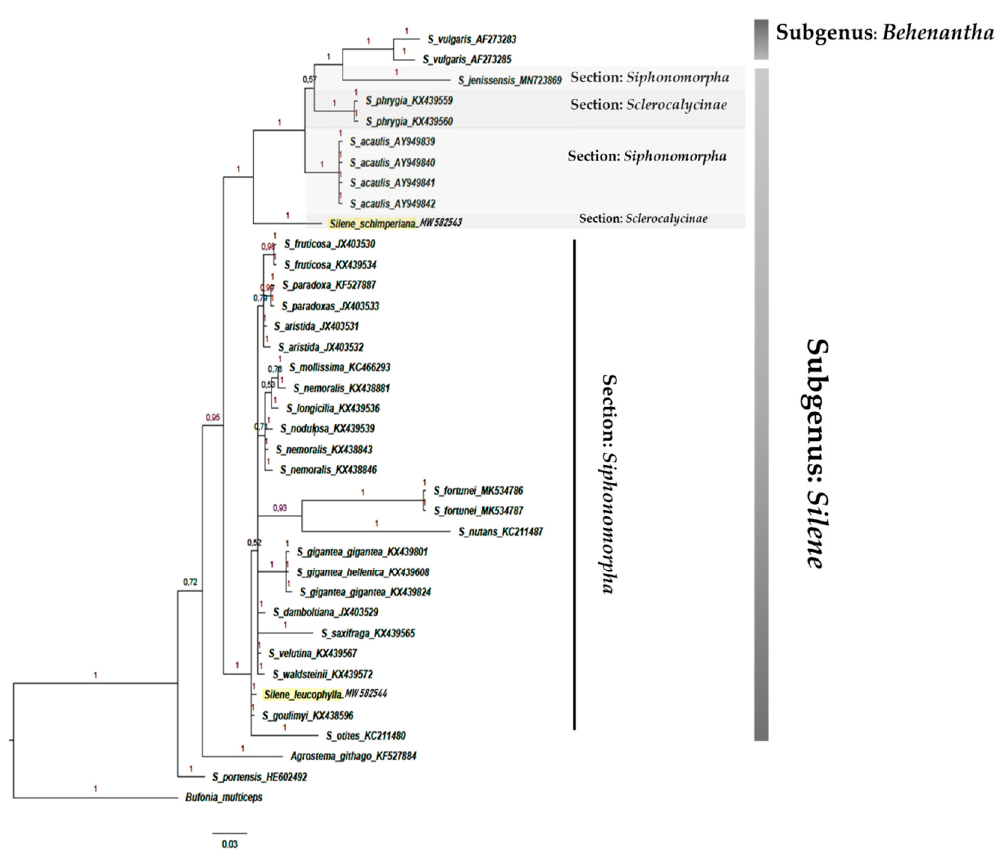
Figure 10. Bayesian phylogenetic tree of Silene species based on cpDNA sequences of the psb -A/ trn -H marker. Numbers Figure 11. Bayesian phylogenetic tree of Silene species based on cpDNA sequences of the rbc L marker. Numbers above above branches represented (PP). branches represented